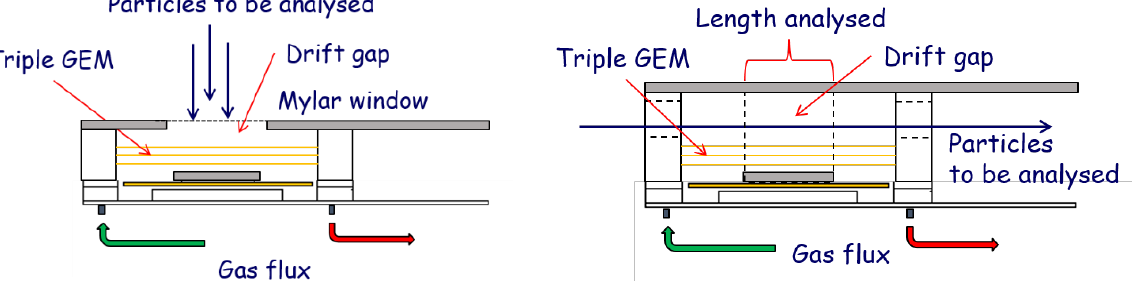
Figure 4. Head-on ( left ) and side-on ( right ) configuration of the GEMPix.